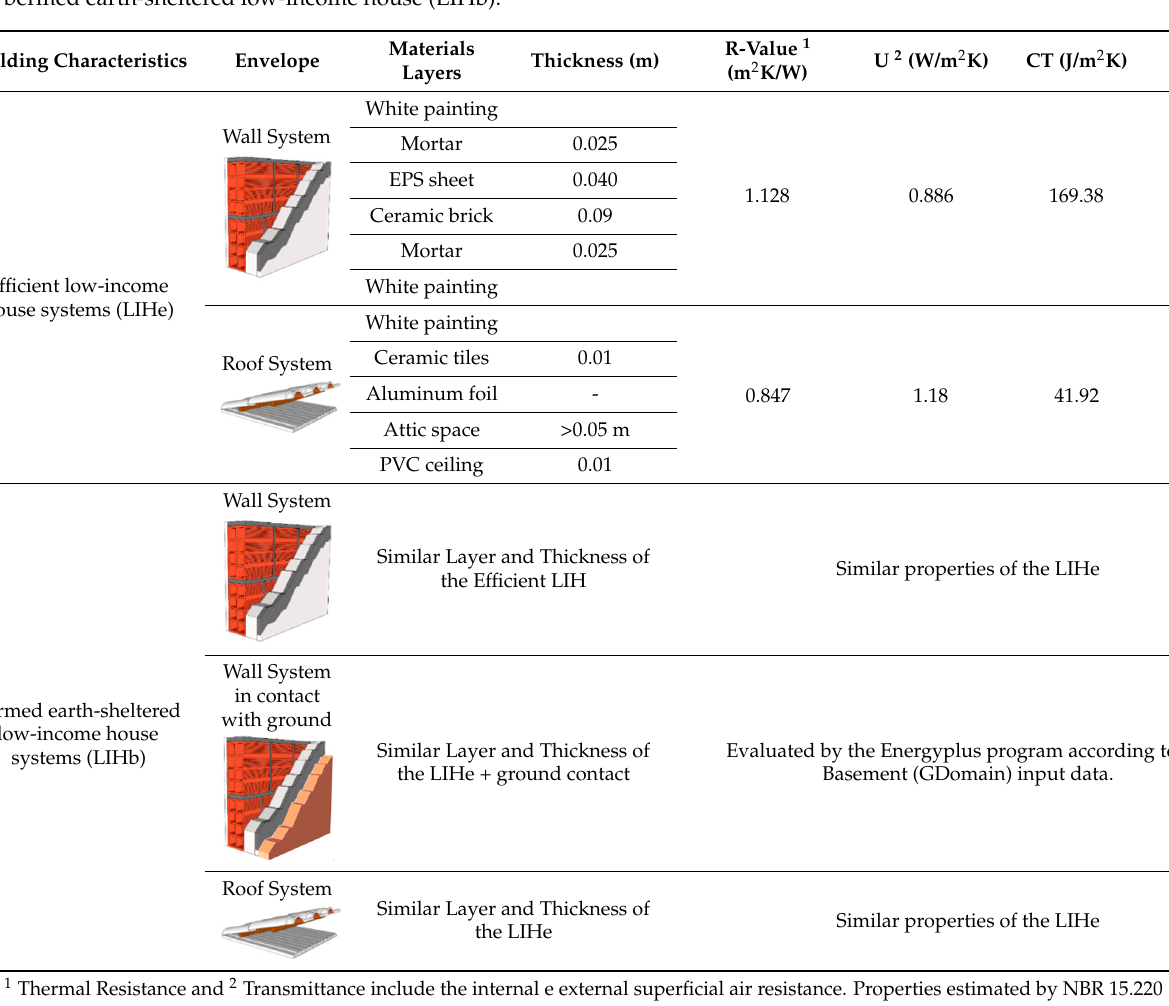
Table 2. Thermophysical properties adopted for building systems envelope of the efficient low-income house (LIHe) and bermed earth-sheltered low-income house (LIHb).